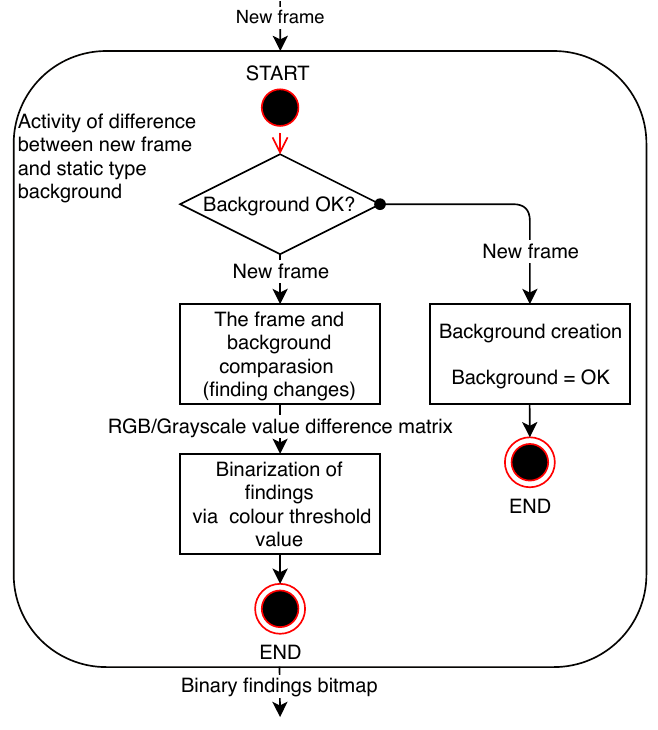
Figure 2. Diagram of the difference method activity towards the static